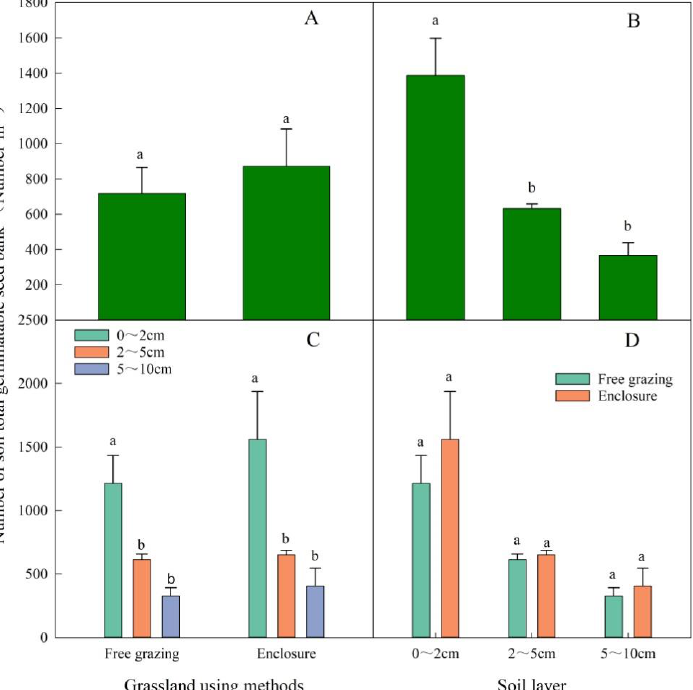
Figure 1. Effects of grassland use methods and soil layer on soil total germinable seed bank. Note: Lowercase letters represent significant differences between different using methods or different soil layers ( p < 0.05). Subfigure ( A ) shows number of soil total germinatable seed bank at 0 – 10cm under different using methods. Subfigure ( B ) shows number of soil total germinatable seed bank of free grazing and enclosure at different soil layers. Subfigures ( C , D ) show number of soil total germinatable seed bank under different using methods and soil layers.